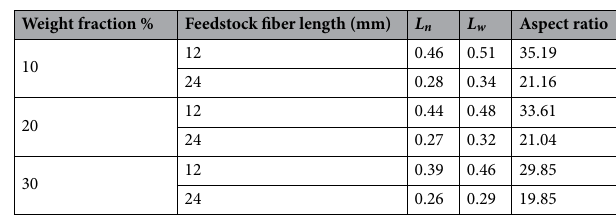
Table 6. The number average fiber length ( L n ) and weight average fiber length ( L w ) of GF-PP composites.